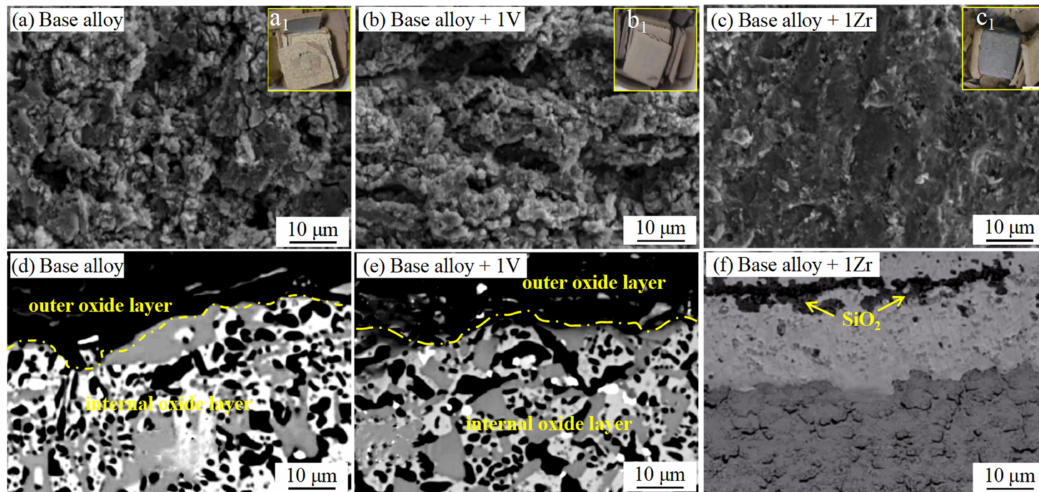
Figure 6. Surface SEM images of Nb-Si-based alloys after oxidation at 1250 ◦ C for 100 h: ( a ) base alloy, ( b ) 1V alloy, ( c ) 1Zr alloy. a1–c1 are the corresponding macroscopic morphology. Cross-sectional SEM images of Nb-Si-based alloys after oxidation: ( d ) base alloy, ( e ) 1 V alloy, ( f ) 1Zr alloy. Copyright 2017 Springer